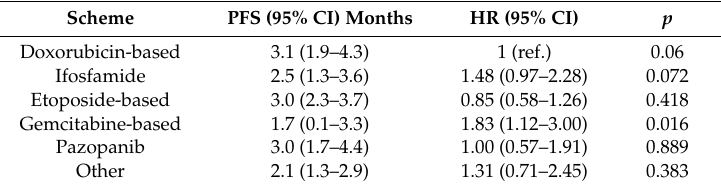
Table A4. Progression-free survival (PFS) on di ff erent systemic therapy regiment irrespective of the line of treatment. HR, hazard ratio in patients receiving chemotherapy alone.